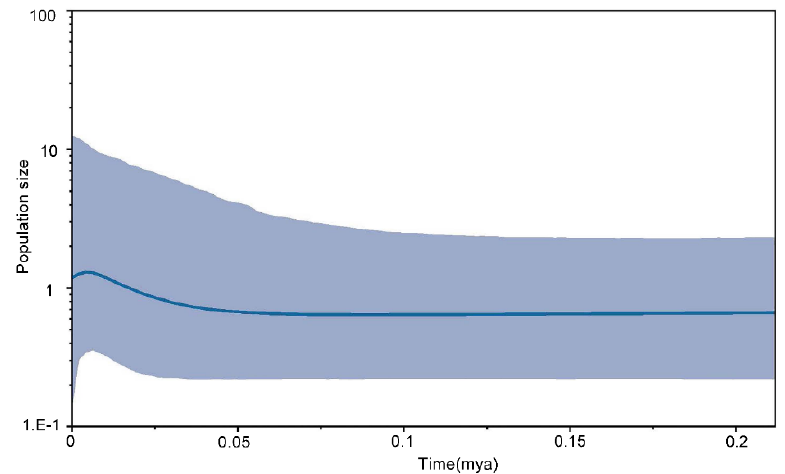
Figure 8. Bayesian skyline plot derived from 1091 bp of D-loop sequences (n = 155). The thick solid line represents the median estimate, and the light blue area corresponds to the 95% highest posterior density (HPD).